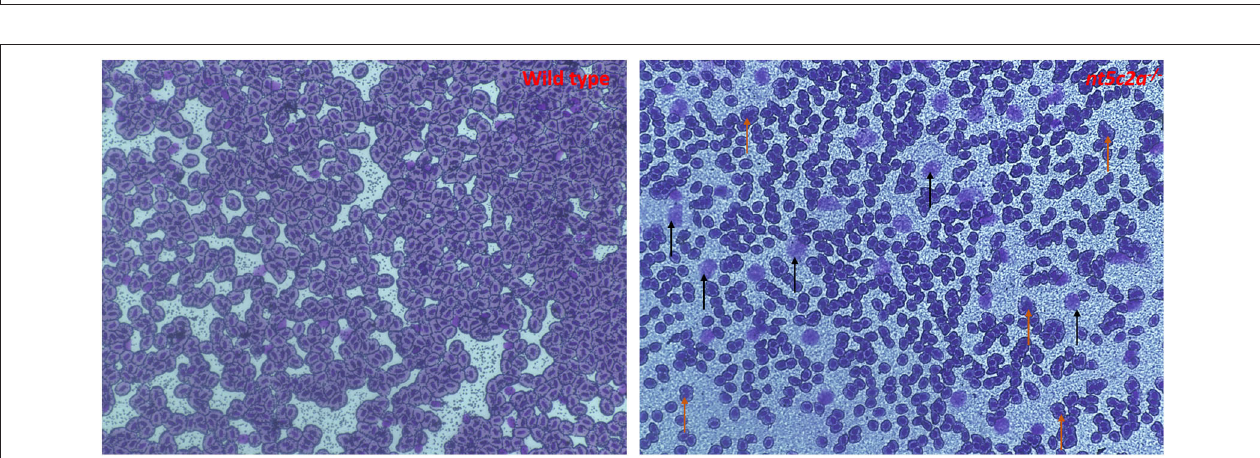
FIGURE 8 | Microscopic images of May-Grünwald-Giemsa–stained blood smear from ab-wildtype and nt5c2a mutant (heterozygote and homozygote) zebrafish larvae ( n = 6 per group). Black arrows on the stained image from nt5c2a mutant represents the groups of immature blood cells without any cytoplasmic material. Images were captured at 40X magnification. Red and black arrows on the stained image from nt5c2a mutants represents the group of multi-nucleated and immature blood cells without any cytoplasmic material respectively.